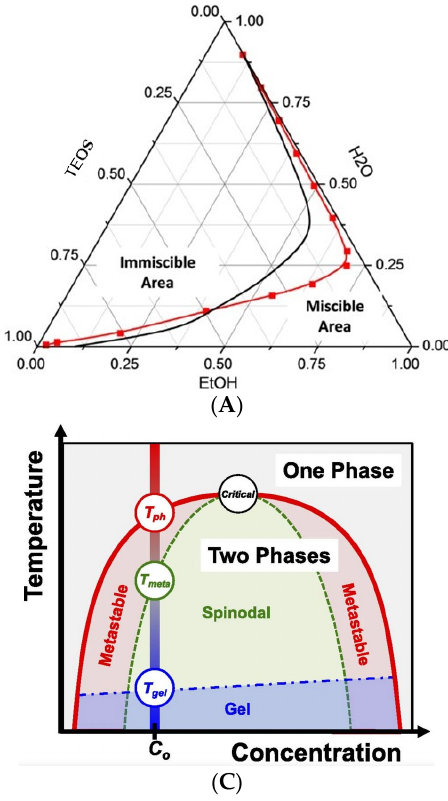
Figure 2. Silica sol–gel system: ( A ) ternary TEOS-EtOH-H 2 O system; ( B ) chemical miscibility/immiscibility between solvents and reactants used in polymer and sol–gel silica systems; ( C ) spinodal phase separation: phase diagram.